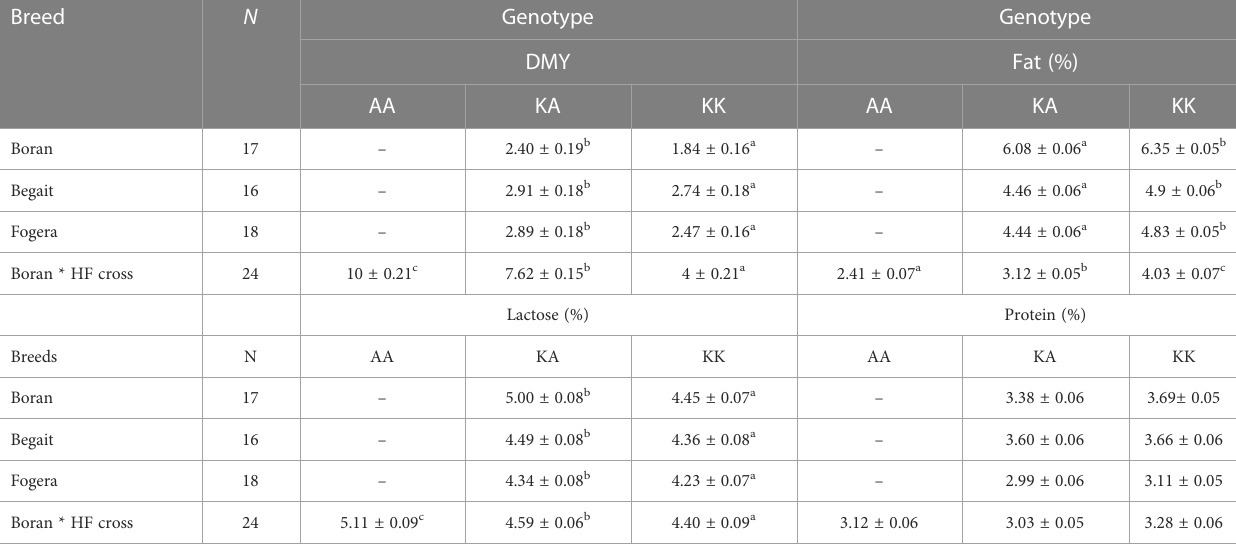
TABLE 3 Effect of DGAT1 K232A genotypes on DMY and composition traits (mean ±